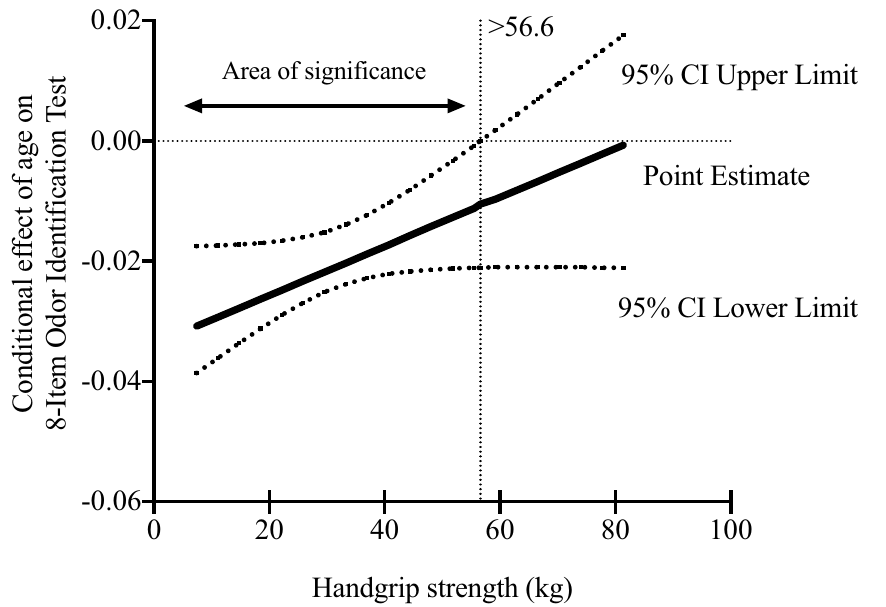
Figure 3. Moderation analysis using the Johnson-Neyman technique. Moderating effect of handgrip strength on the relation between age and olfactory function. Data are presented as a regression point estimate (beta unstandardized) and 95% confidence intervals. Adjusted by sex, race/ethnicity, ratio family income to poverty, marital status, education level, dietary intake, smoking status, alcohol consumption and self-reported chronic